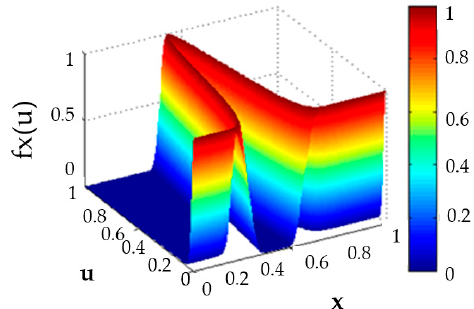
Figure 3 . Generalized Type-2 membership function.